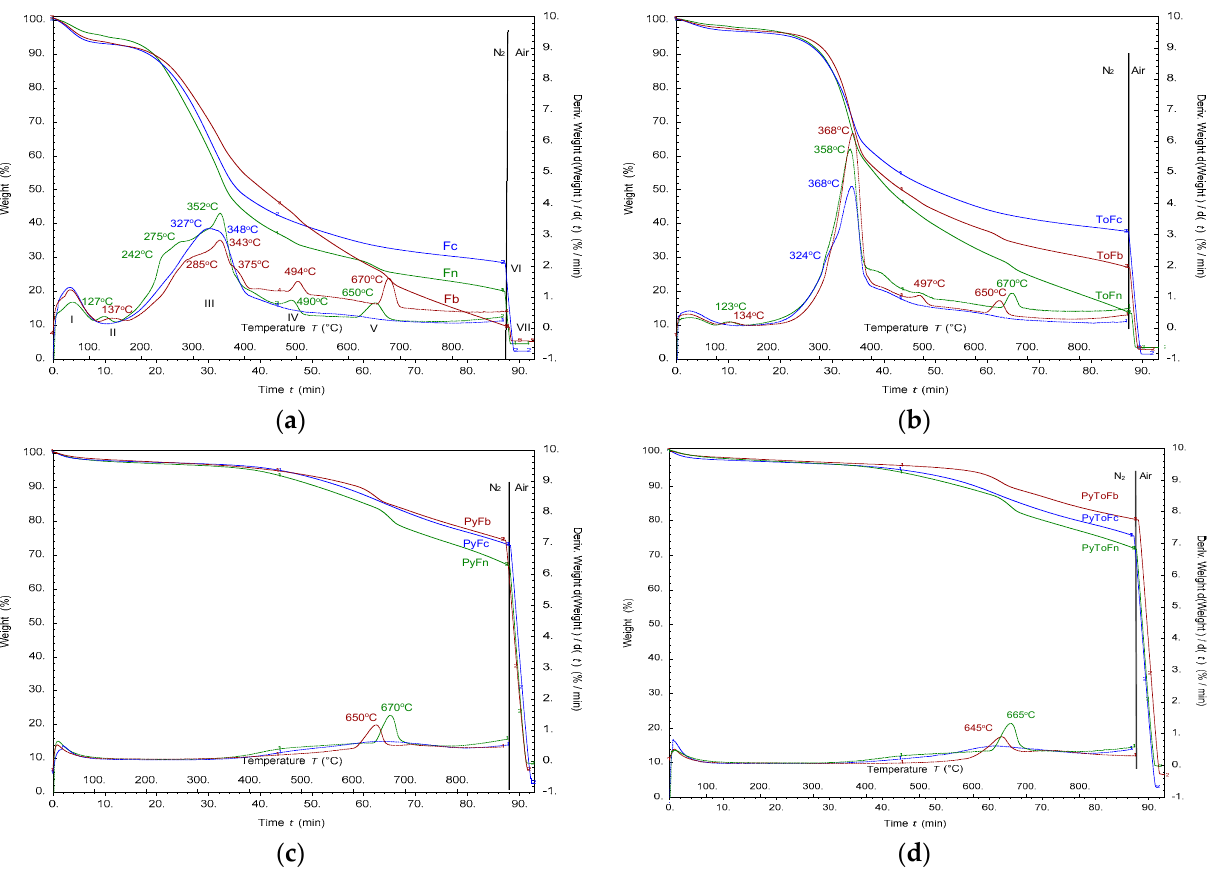
Figure 6. The TG and DTG curves of needles, cones and bark from fir ( a ) and of their solid residue after torrefaction ( b ), pyrolysis ( c ) and combined torrefaction + pyrolysis ( d ).